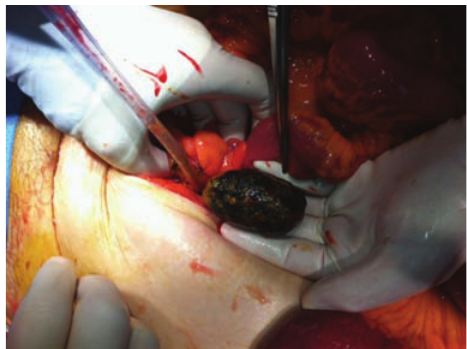
Figure 5: Surgical removal of the obstructing gallstone.